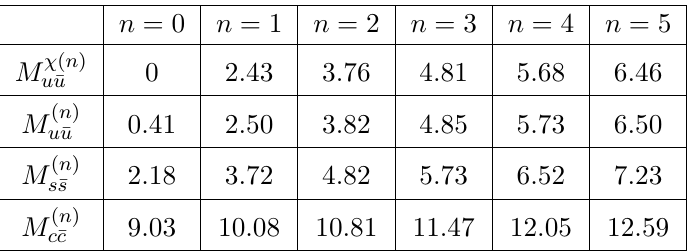
Table 1 . Mesonic mass spectra of the u (cid:22) u (as well as for the massless u quark), s (cid:22) s and c (cid:22) c families. The results are obtained from solving ’t Hooft equation, as well as from solving the BG equation in di(cid:11)erent reference frames. The respective spectra obtained from di(cid:11)erent approaches are always compatible with each other, at least agree at the second decimal digit.